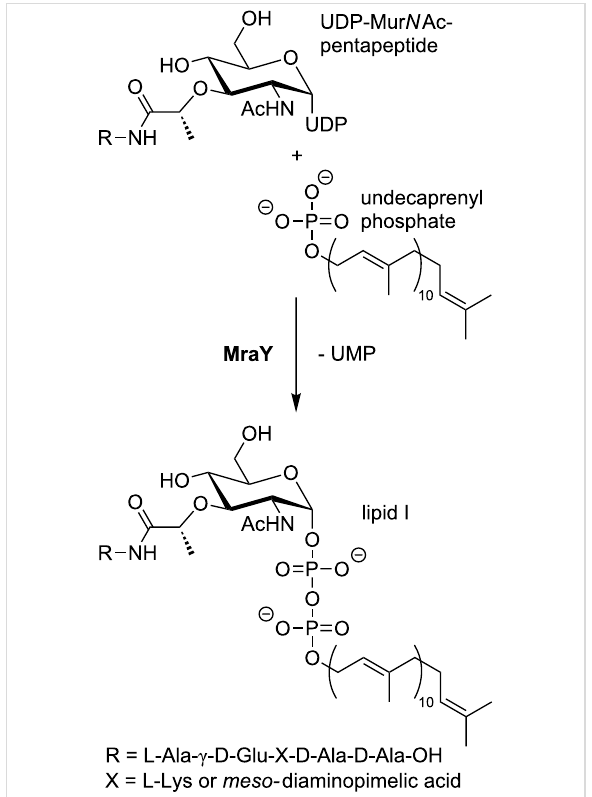
Figure 5: Translocase I (MraY) catalyses the reaction of UDP- Mur N Ac-pentapeptide with undecaprenyl phosphate towards lipid I.